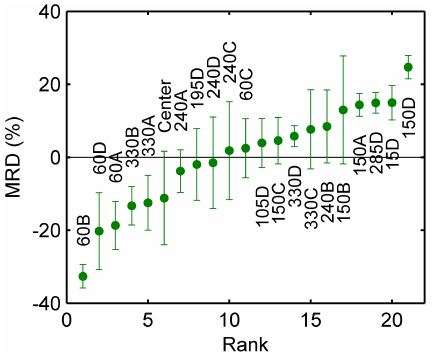
Figure 5. Average mean relative difference (MRD) ± 1SD for each neutron probe monitoring location.